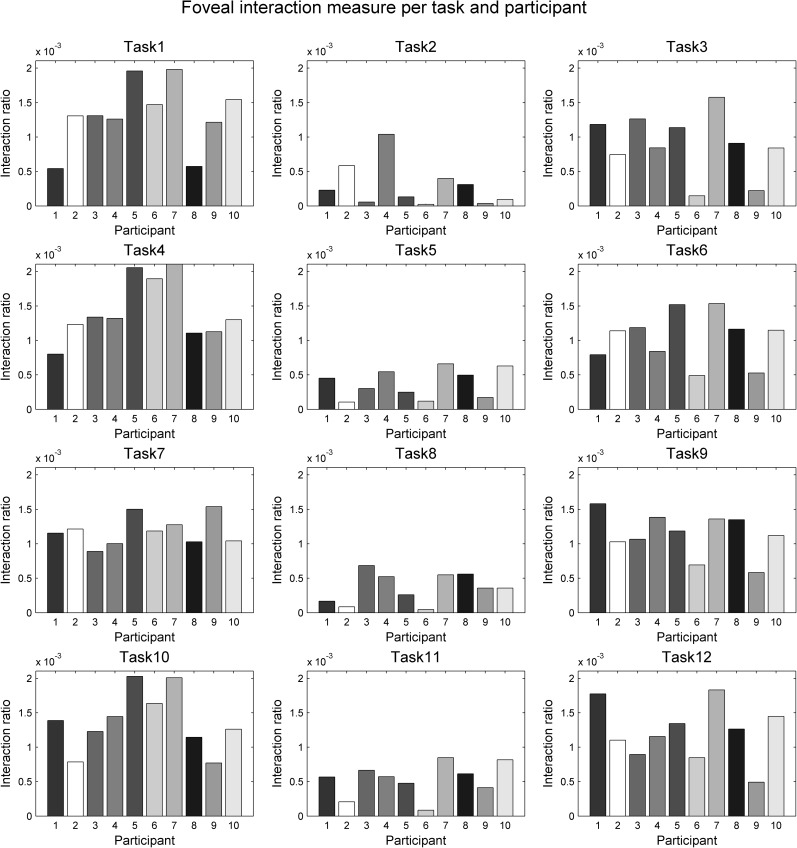
Quantifying foveal interaction.Plots are shown for tracing the circle (tasks 1–3), the rectangle (tasks 4–6), the curve (tasks 7–9) and the star (tasks 10–12). Each row shows three charts: for natural tracing, for eye-first and for mouse-first. Participants are ordered in the same way across all charts and all charts are shown at the same scale, to allow for visual comparison of charts across each geometric form (per row) and across each participant (per each bar in each chart). Bars are coloured per participant in this and the next figure (parafoveal interaction).